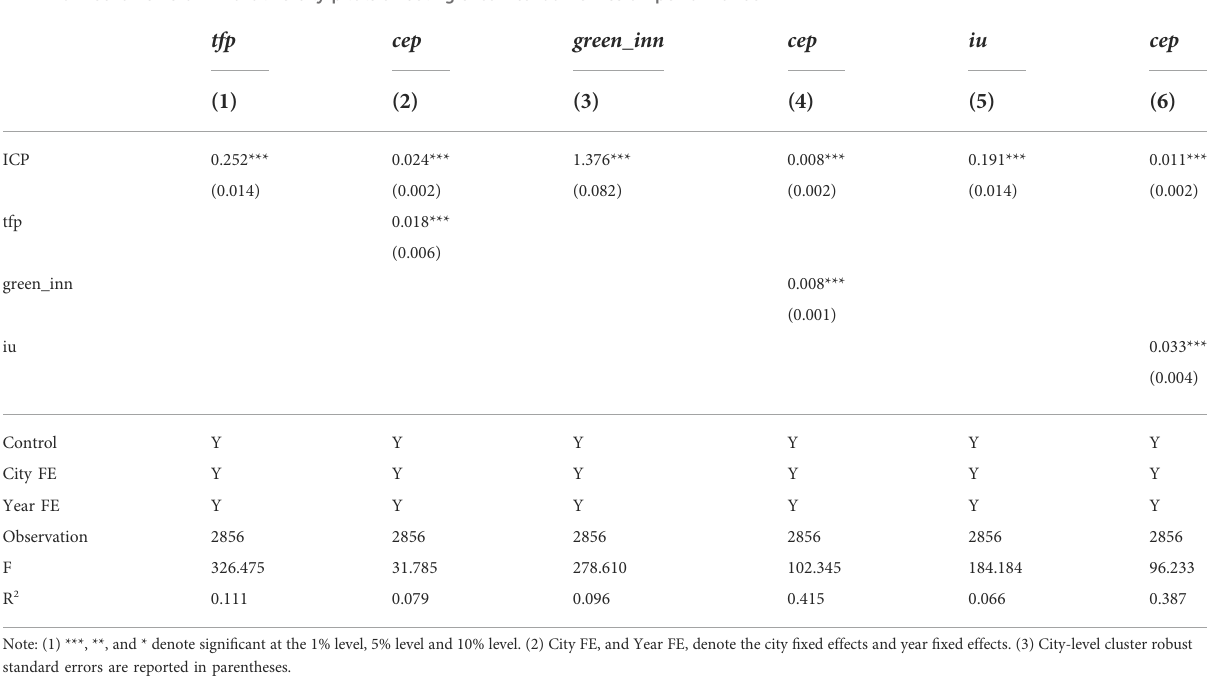
TABLE 6 Mechanisms of innovative city pilots affecting urban carbon emission performance.